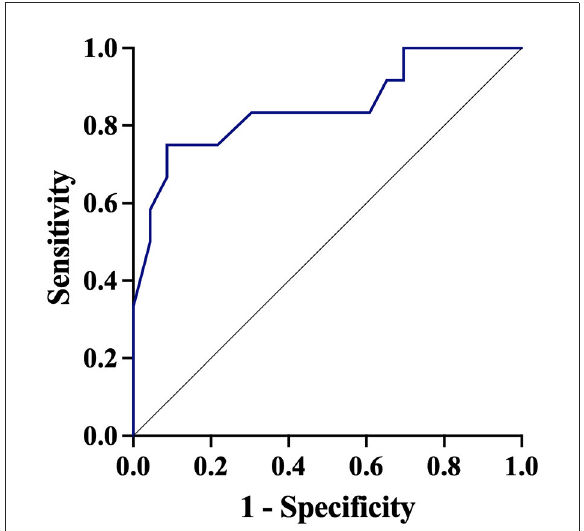
FIGURE2 Receiver Operator Curve (ROC) of baseline brain oxygen pressure (PbtO 2 ) to predict a significant PbtO 2 increased after therapy.